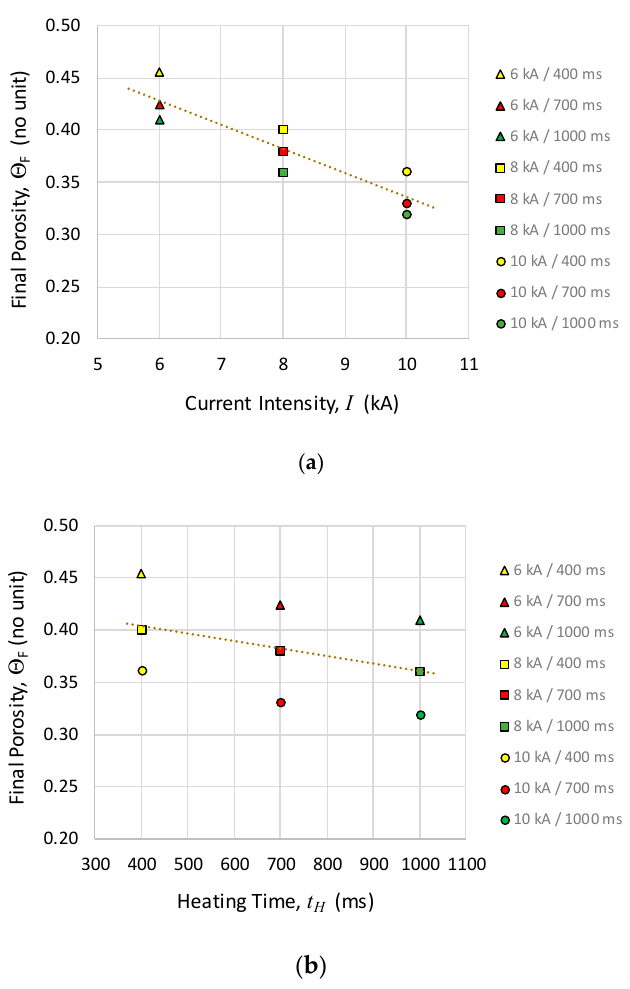
Figure 7. Final porosity of the compacts ( Θ F ) against: ( a ) the current intensity and ( b ) the heating time, for the different MF-ERS experiments. The dotted lines in both graphs represent the trend of the whole set of points.